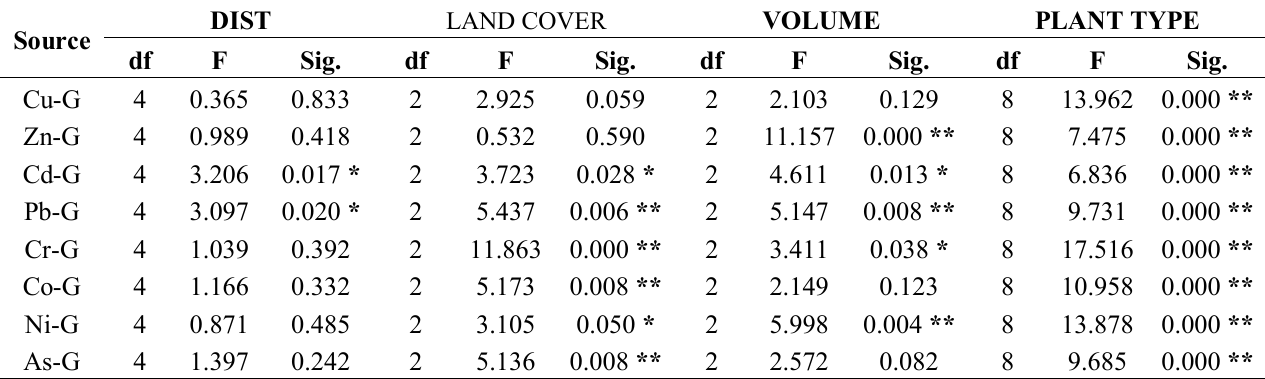
Table 7. MANOVA results of trace element concentrations for Grass Samples. DIST LAND COVER Source